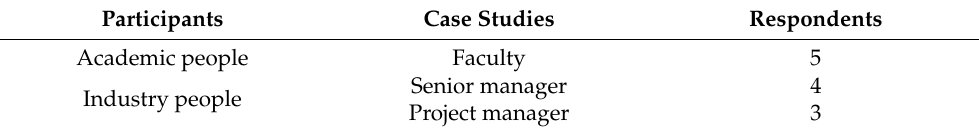
Table 3. Participants in Demetel method and structural interpretive